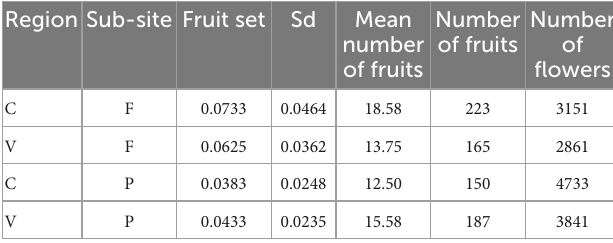
TABLE 2 Summary of Rodriguezia granadensis fruit set for forest (F) and pasture (P) sub-sites in two regions, Cauca (C) and Valle (V), Colombia. Region Sub-site Fruit set Sd Mean